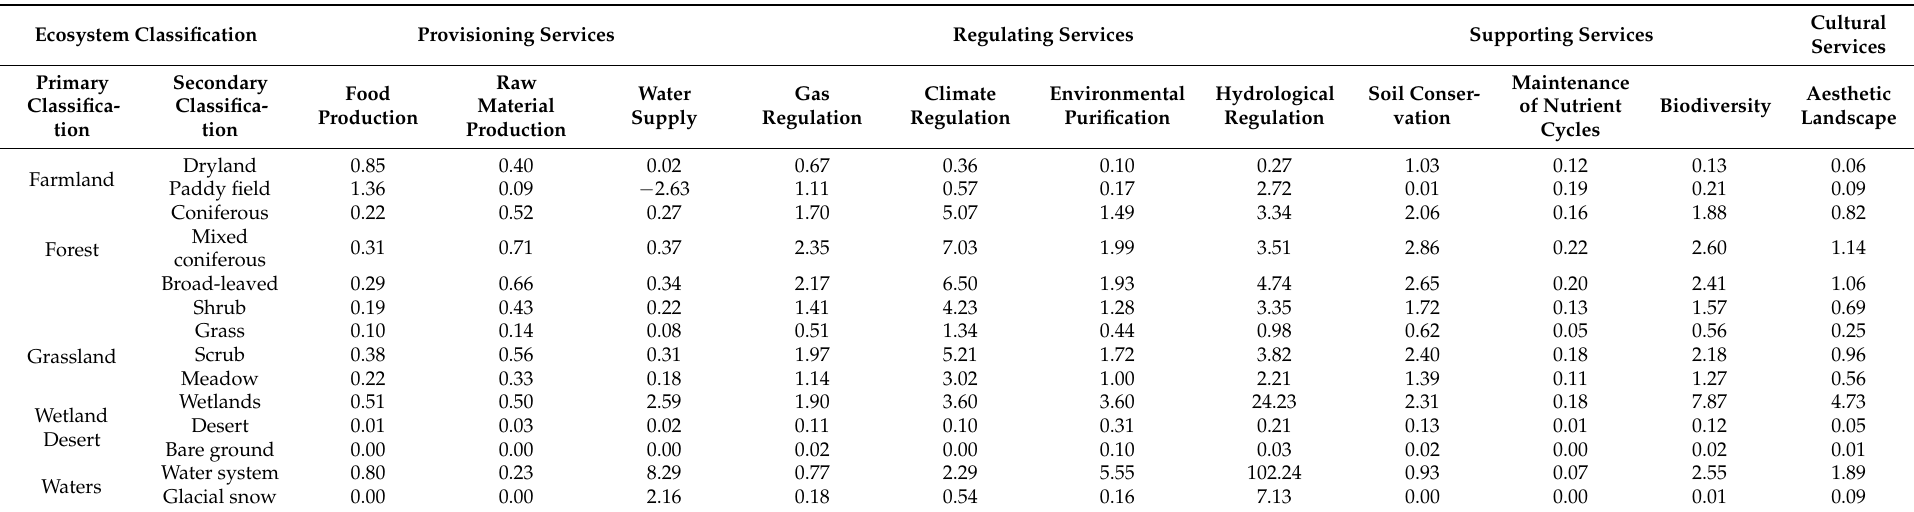
Table A3. Ecosystem service equivalent value per unit area